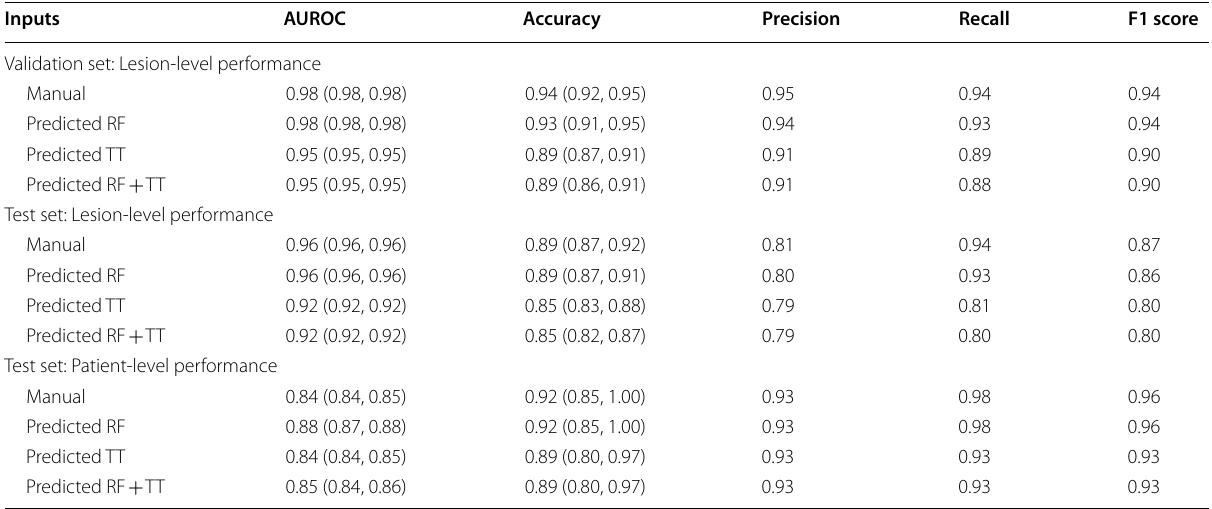
Table 3 Performance on PCa